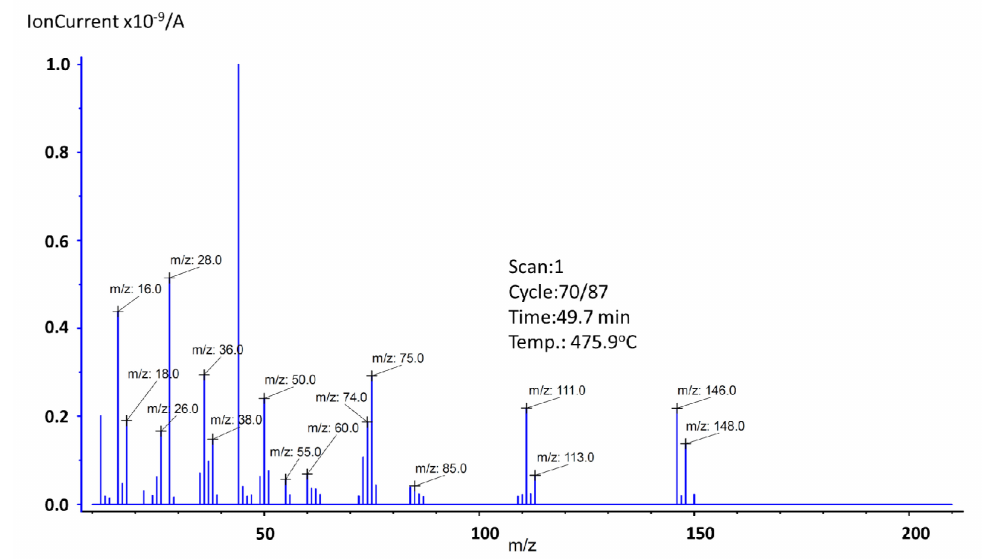
Figure 5. Mass spectra of Tb2,6DClB at the exothermic maximum 478.5 ◦